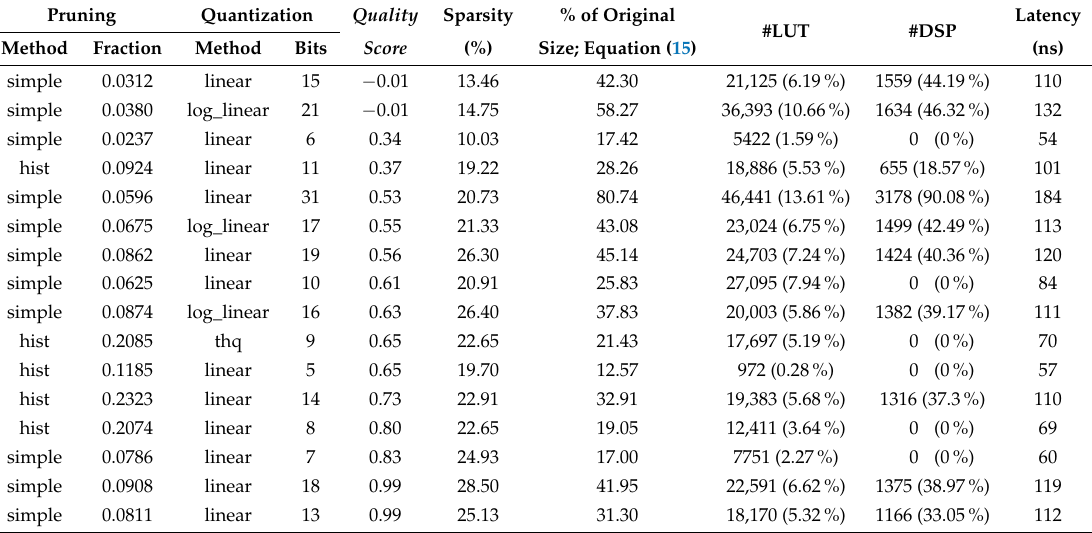
Table 2. [PM2.5] Selected results for pruned and quantized model. Percentages in the ‘#LUT’ and ‘#DSP’ refer to the overall resources available on the chip. Full results are available in Table